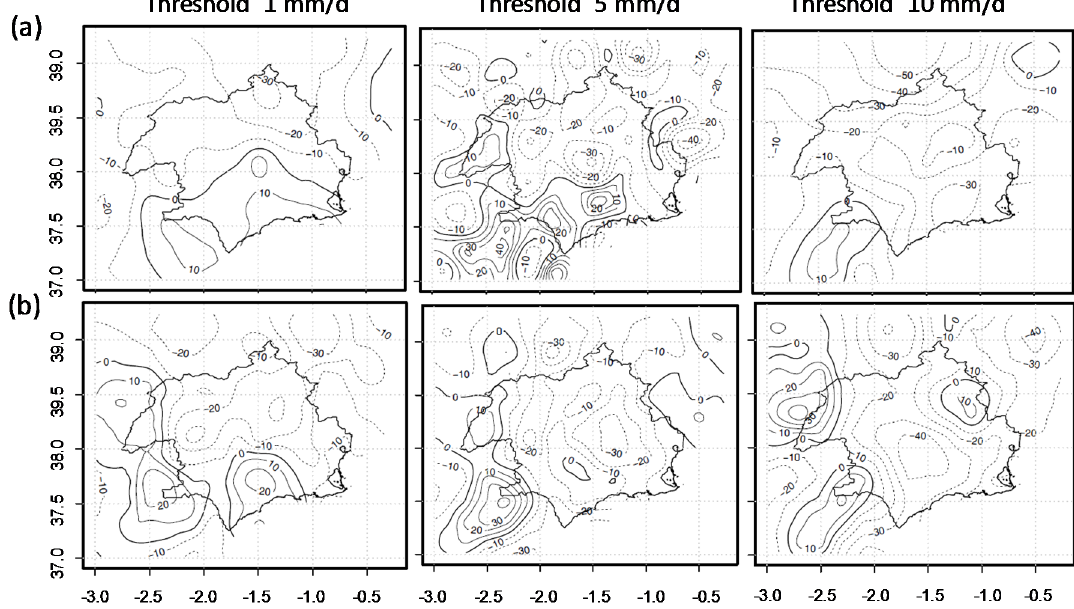
Figure 12. Spatial pattern of differences (Dif %) of MDSL, from GAMLSS analysis on each site for Tr = 25 years and thresholds: ( a ) Dif (1980–1950)/1950; ( b ) Dif % (2007–1980)/1980. Dashed lines represent negatives